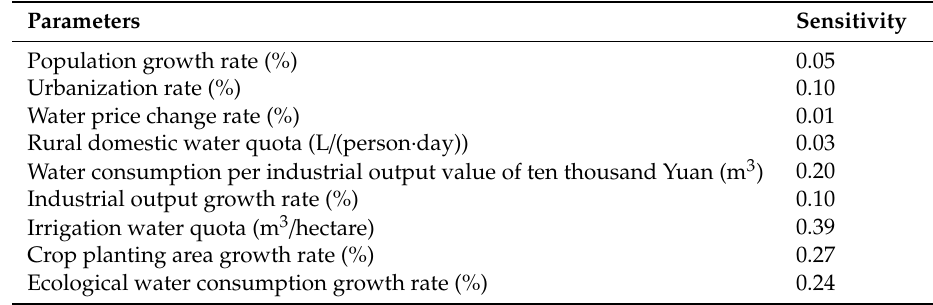
Figure 5. Historical test results of main variables. ( a – f ) are comparisons between simulated data and statistical data for total water consumption, irrigation water consumption, crop planting area, industrial output value, population, and ecological water consumption, respectively. Table 2. Sensitivity test results of main parameters.